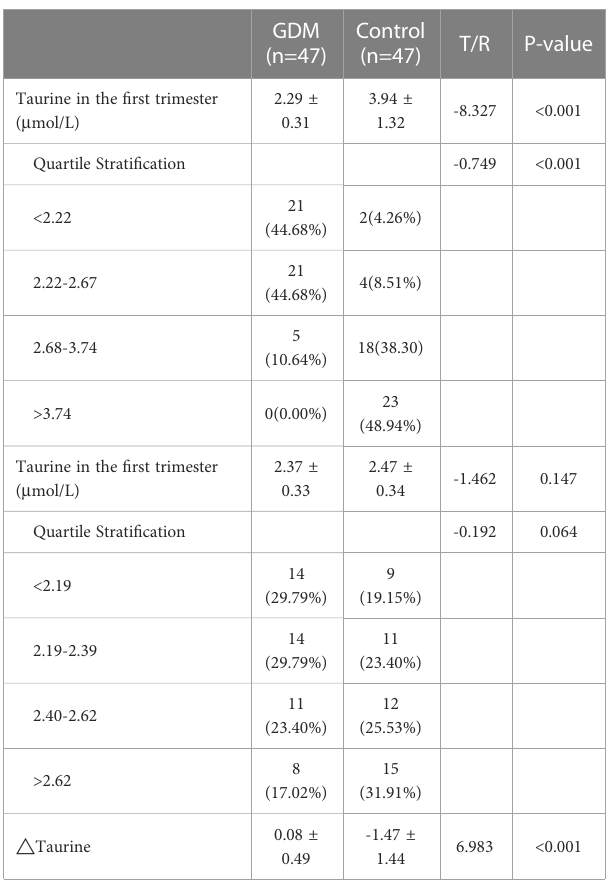
TABLE 2 Serum taurine concentration and quartile strati fi cation comparison between two groups.